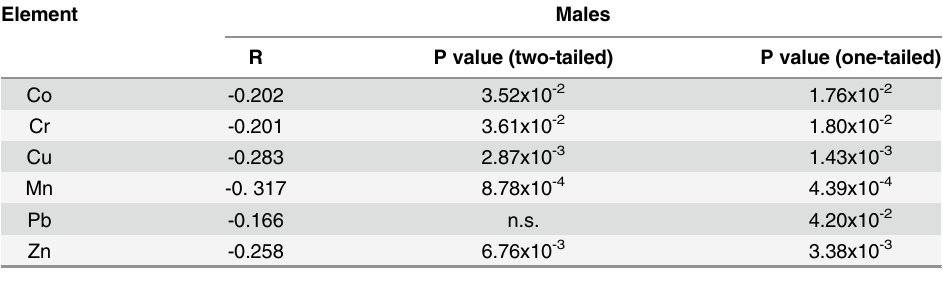
Table 4. Correlation coefficients between geochemical elements and T1D incidence rates in males.